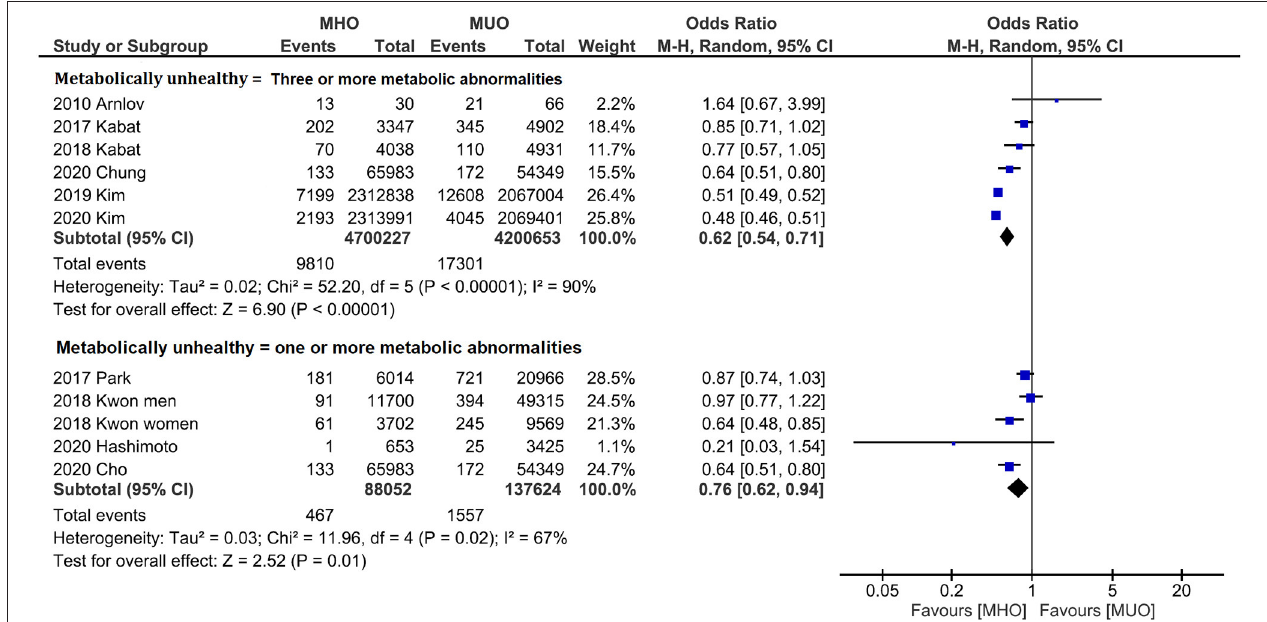
FIGURE 5 | Subgroup analysis grouped by the definition of metabolically status. Lower cancer incidence for metabolically healthy obesity phenotype is found in both studies defining three or more metabolic abnormalities as metabolically unhealthy and studies defining one or more metabolic abnormalities as metabolically